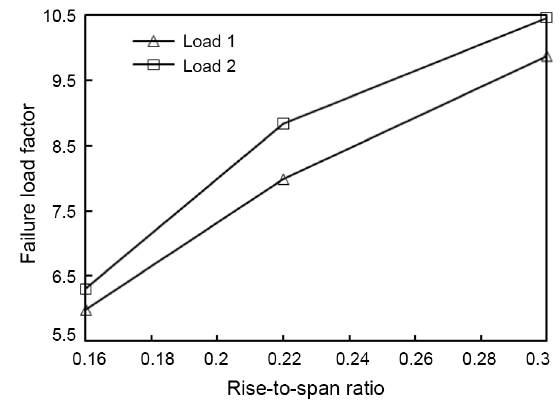
Fig. 12. Failure loads with different rise-to-span ratios